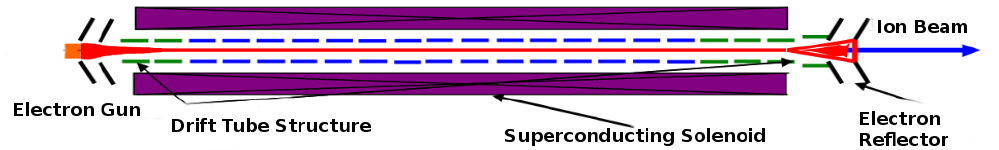
Figure 1. Electron String Ion Source scheme. Neutral atoms or molecules are injected into the drift tube where an electron string is formed and where they undergo electron-impact ionization. Combination of drift structure and electron string potentials allows to hold the ions long enough to achieve high degree of ionization. Typical length of the electron string is 1m and string radius is 0 .